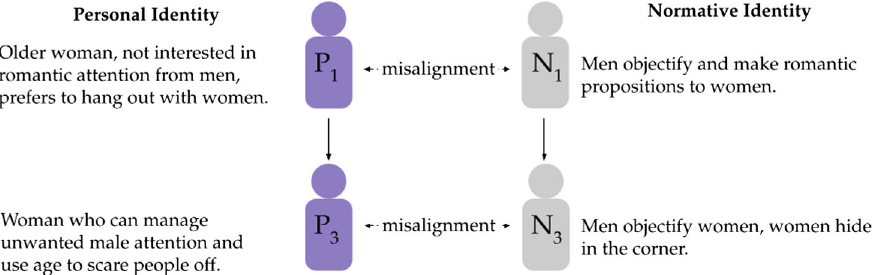
FIG. 2. Summary of Cassidy ’ s personal identity and perceived normative identity with respect to objectification of women from